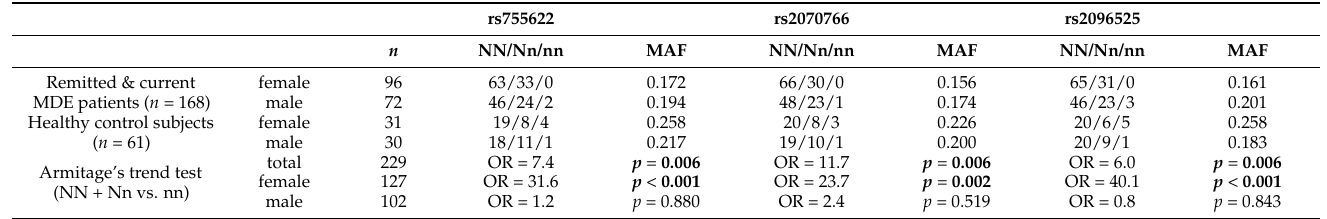
Table 2. Genotype frequencies and odds ratios (OR) for NN + Nn vs. nn for MIF SNPs suggest a protective effect of the minor allele homozygous genotype for MDD in